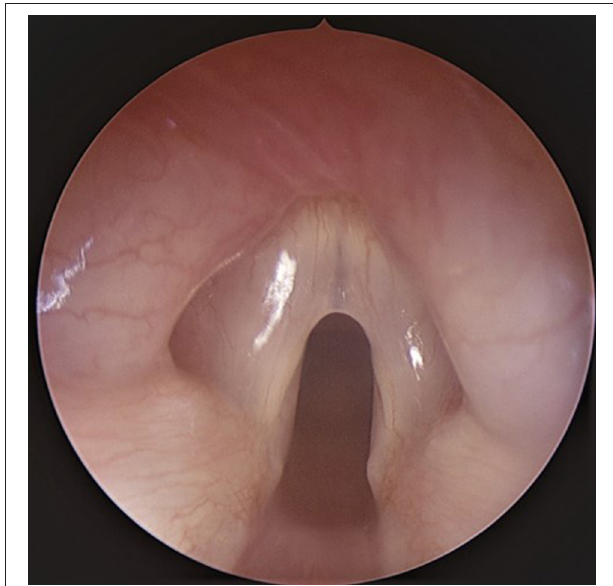
FIGURE 1 | Endoscopic view of Type 2 laryngeal web.